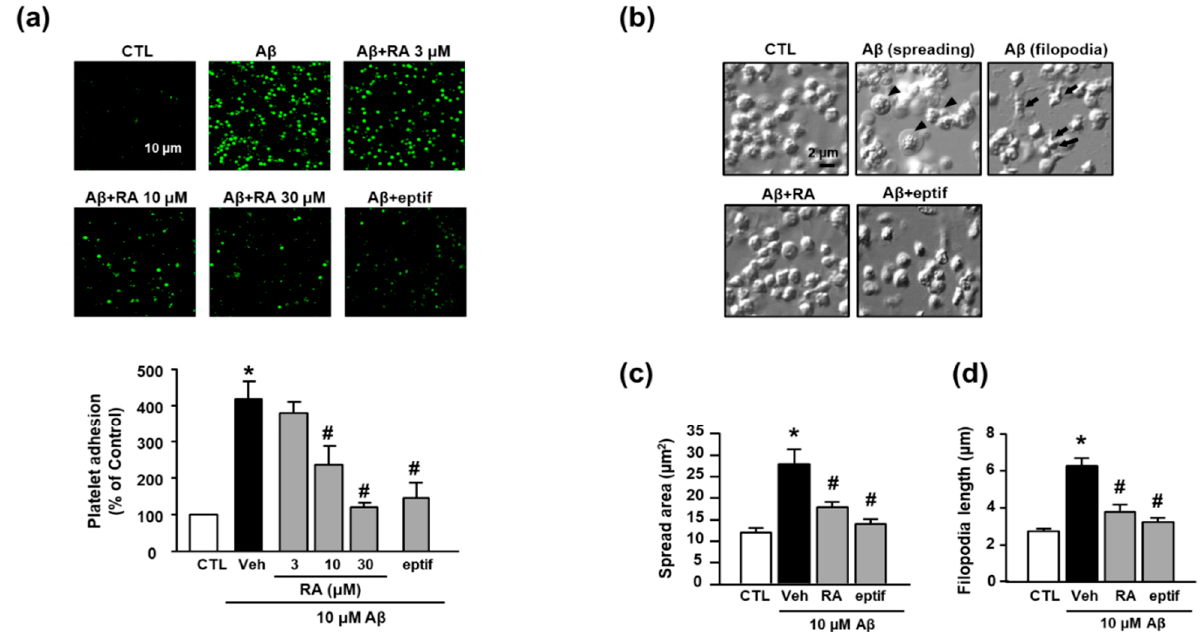
Figure 1. RA reduces A β 1–40 -induced platelet adhesion possibly through blockade of integrin α IIb β 3 . ( a ) Representative fluorescence image (upper) and quantitative analysis (bottom) of platelet adhesion to fibronectin. Platelet adhesion (green) was quantified following stimulation with 10 μ M A β 1–40 for 1 h, with or without RA (3, 10, and 30 μ M) and 50 μ M eptifibatide (eptif, an integrin α IIb β 3 inhibitor) pretreatment for 30 min on fibronectin-coated coverslips. Data are presented as the mean ± SEM of five experiments. Scale bars represent 10 μ m. ( b ) DIC images representative of platelet adhesion to fibronectin. Arrow- heads and arrows indicate spreading and filopodia formation of platelets, respectively. Platelets were stimulated with 10 μ M A β 1–40 for 1 h, with or without 30 μ M RA and 50 μ M eptif pretreatment for 30 min. Scale bars represent 2 μ m. ( c ) Quantitative analysis of the surface area of platelet spread; ( d ) quantitative analysis of filopodia length of platelets. Data are presented as the mean ± SEM in five or more random fields in three separate experiments. * p < 0.05 compared with CTL, # p < 0.05 compared with Veh. RA, rosmarinic acid; SEM, standard error of the mean; DIC, differential interference contrast; Veh, vehicle; CTL, control.